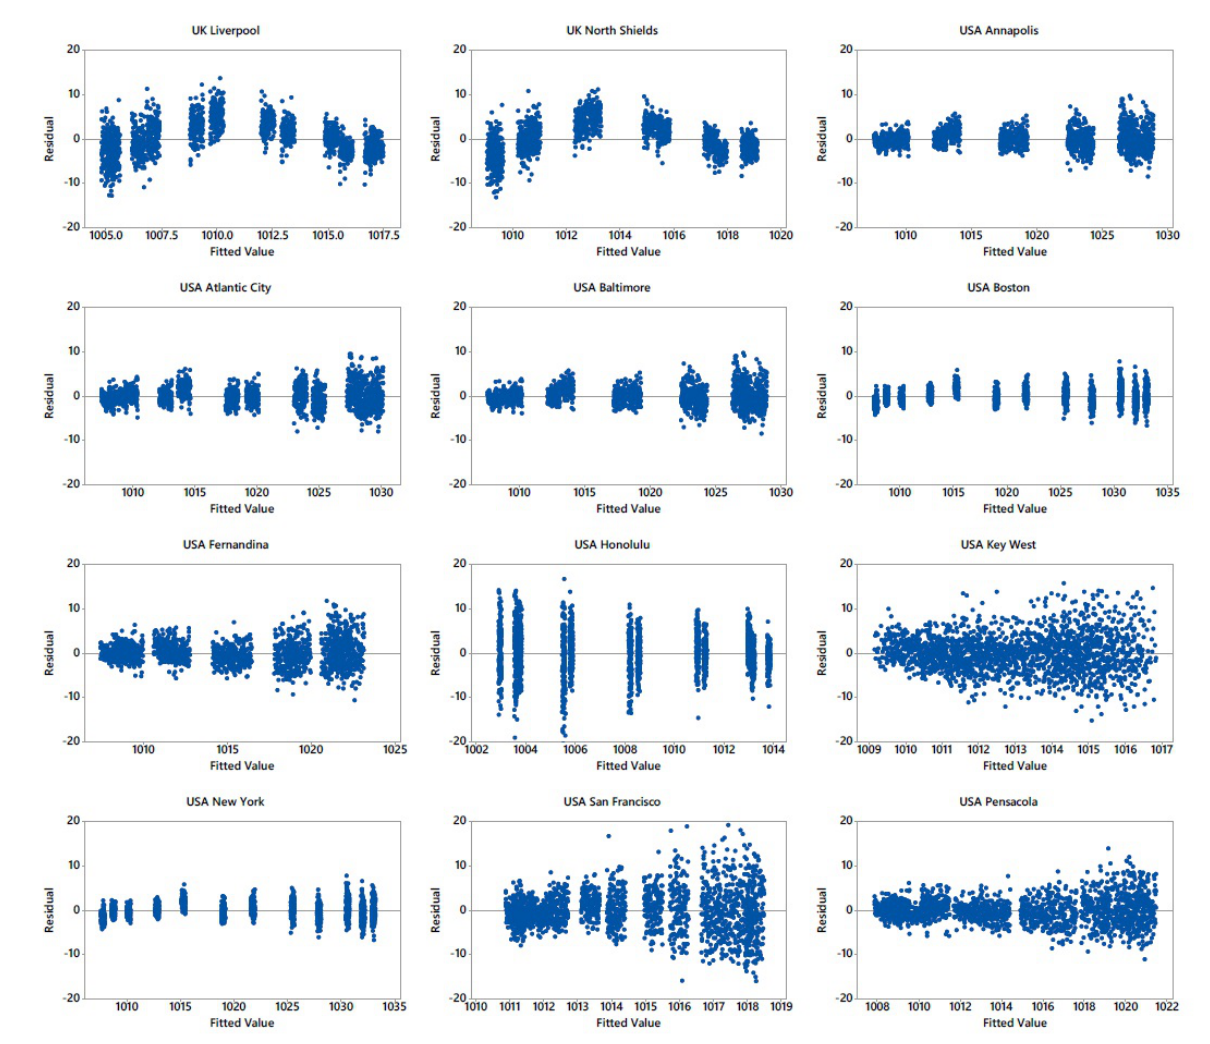
are assumed to be uncorrelated⁶ with zero expected value and homoscedastic in nature since the effect of the non- homogeneity did not impact the solution statistics signifi- cantly. Table 1 lists all the solution statistics calculated us- ing the above model. All the results conform with the ear- lier findings. Stations along the eastern United States are subject to periodic changes with larger amplitudes as com- pared to the others. Stations closer to the equator are also exposed to yearly periodic variations but with smaller am- plitudes. Large adjusted R 2 values show that the models explain most of the variations in atmospheric